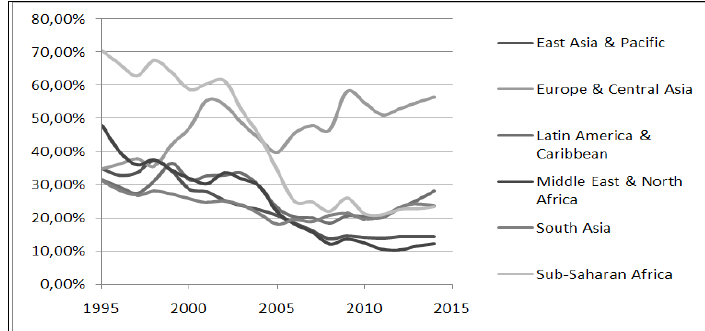
Fig. 5. Trends in total gross external debt to GDP